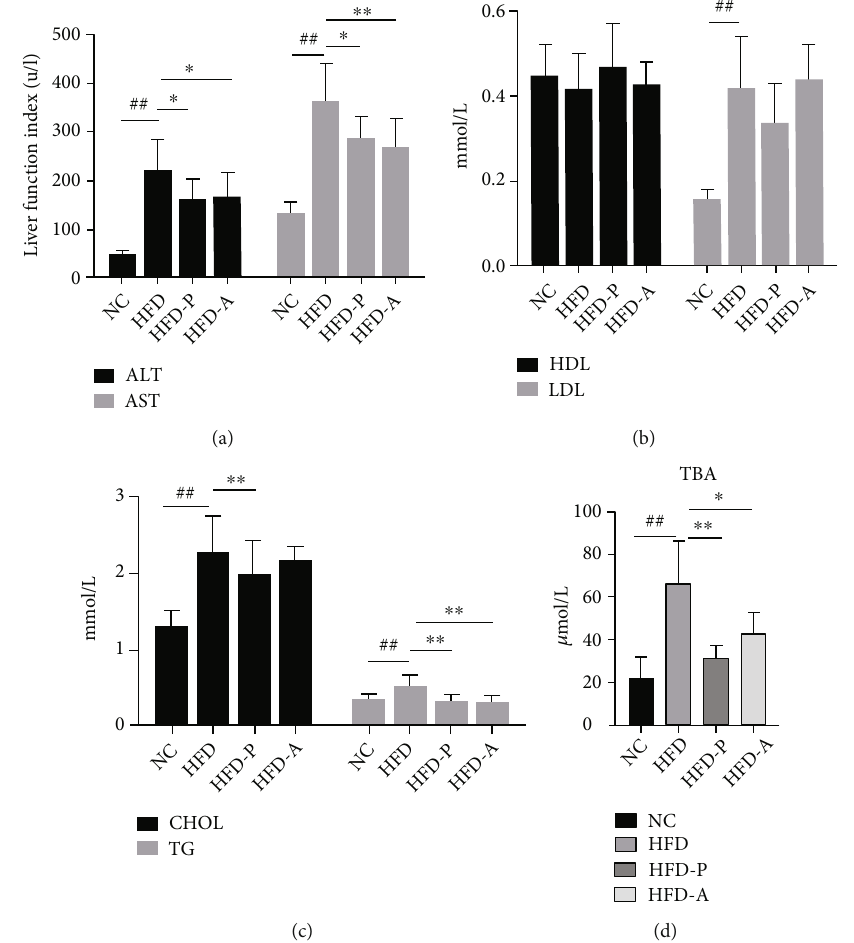
Figure 3: Biochemical index changes in all groups: (a) the levels of ALT and AST; (b) the levels of HDL and LDL; (c) the levels of CHOL and TG; (d) the level of TBA. # P < 0 : 05 and ## P < 0 : 01 versus the NC group; ∗ P < 0 : 05 and ∗∗ P < 0 : 01 versus the HFD